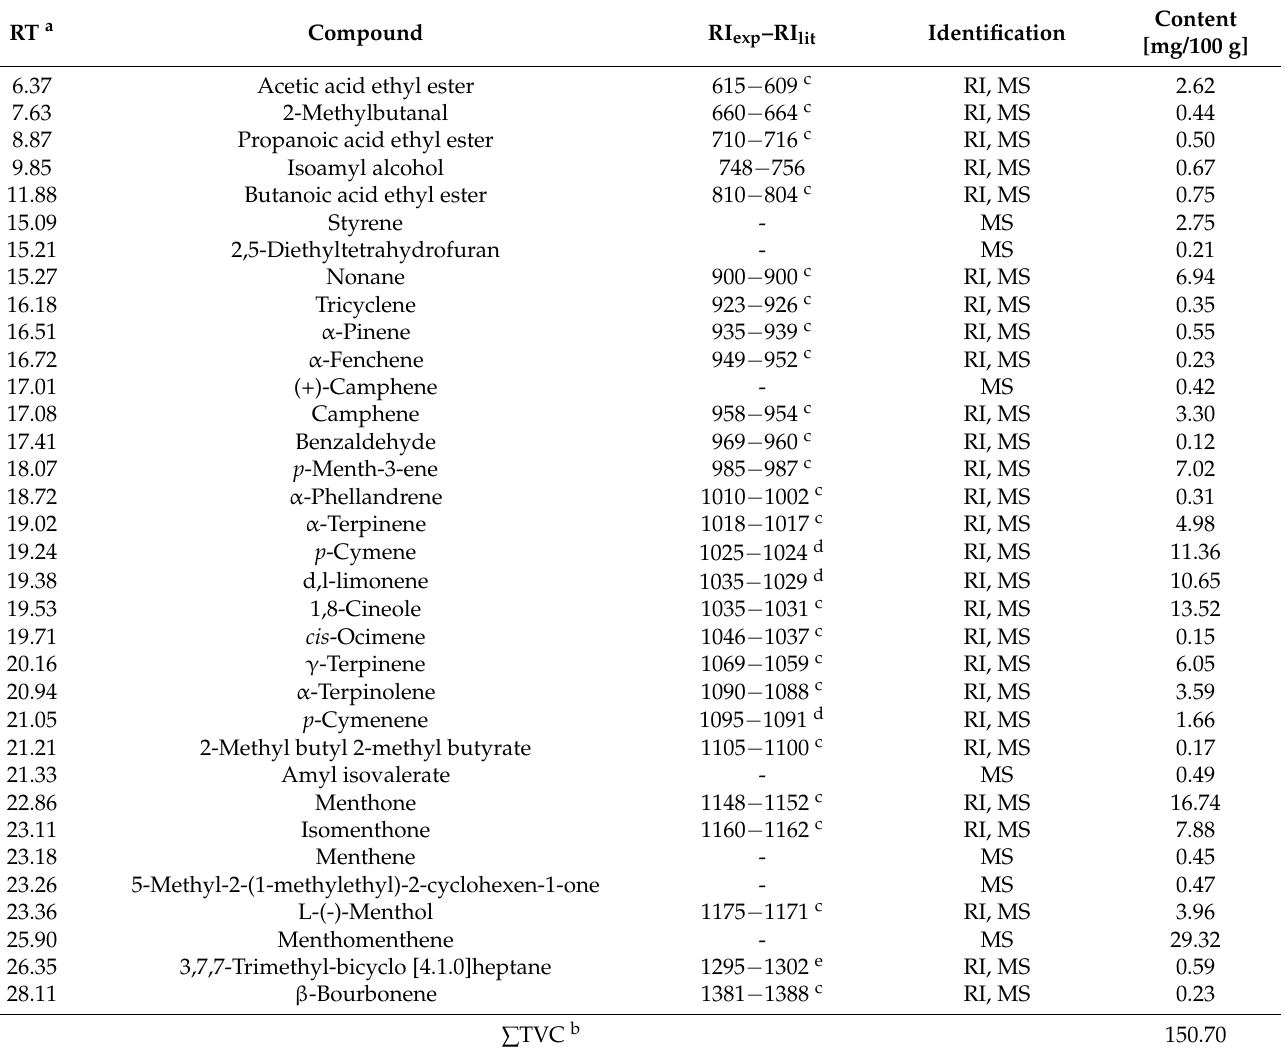
Table 3. Chemical profile of volatile compounds determined by GC-MS in M. piperita extract obtained at 600